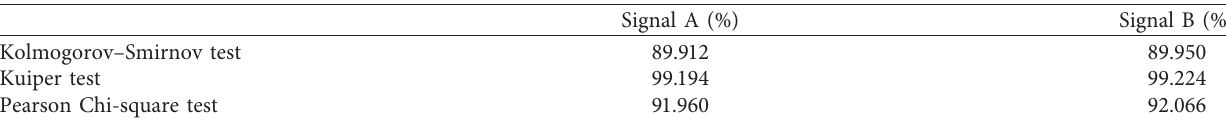
Figure 10: Comparison of the cumulative probability with the cumulative relative frequency of a healthy motor and a faulty motor using the Chi-square test. Table 2: Accuracy of